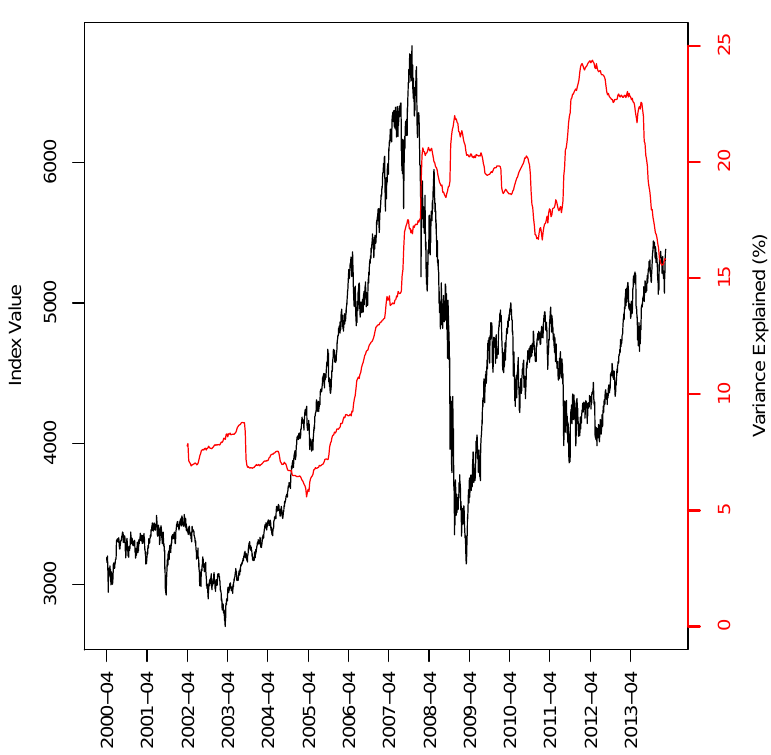
Figure 2. The variance explained by PC1 (right hand aixs, red line) with the ASX200 index value (left hand axis, black line). The plot of index values includes the first two-year period used for the estimation of the